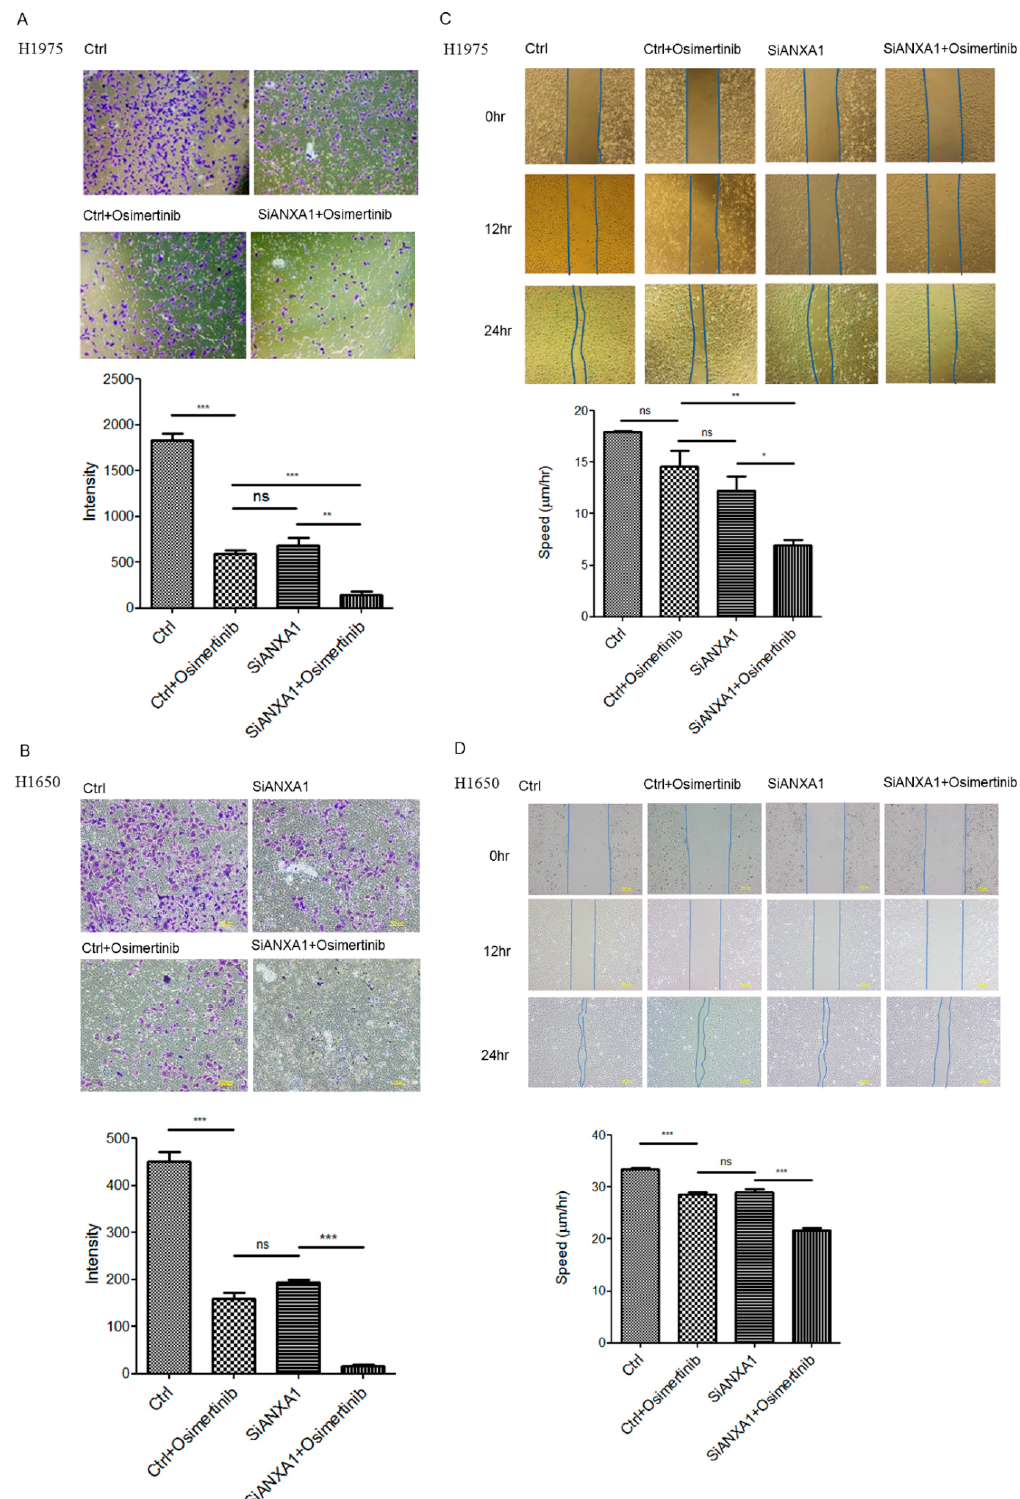
Figure 3. Invasion assay in ( A ) H1975 and ( B ) H1650 lung cancer cells after transfection of 50 nM scrambled control (Ctrl) and ANXA1 (SiANXA1) siRNA with or without 10 nM Osimertinib for 72 h. Intensity of cells is represented as bar ± standard deviation in triplicate experiments. Wound healing assay in ( C ) H1975 and ( D ) H1650 lung cancer cells after transfection of 50 nM scrambled control (Ctrl) and ANXA1 (SiANXA1) siRNA with or without 10 nM Osimertinib for 12 and 24 h. The speed of cellular migration at 24 h is represented as bar ± standard deviation in triplicate experiments. “ ns ” denotes nonspecific. “*” denotes p < 0.05; “**” denotes p < 0.01; “***” denotes p <